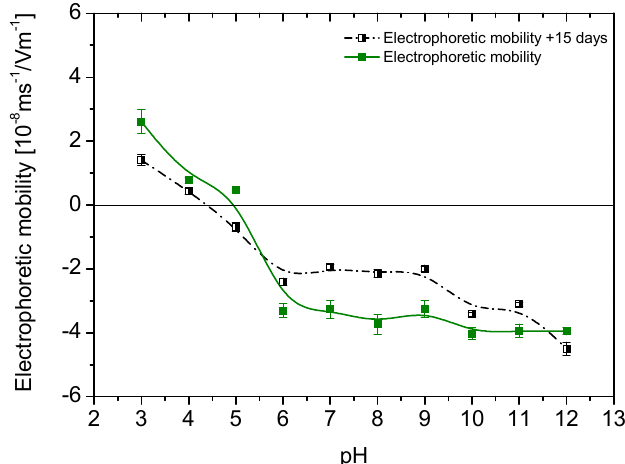
Figure 6. Electrophoretic mobility vs. pH for magnetite immediately after phase transfer to water, and after 15 days stored at room temperature in aqueous medium.